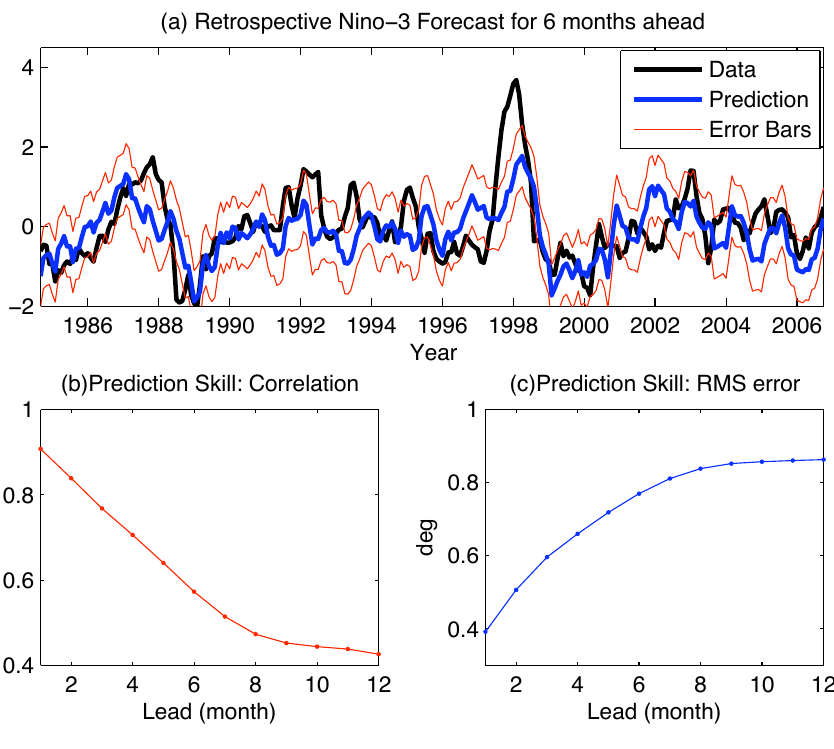
Fig. 14. ENSO forecasts by the SSA-MTM method. (a) Retrospective forecasts of the Ni˜no-3 SST anomalies for a lead time of 6 months. The forecasts (blue curve) for each point in the interval January 1984–February 2006 utilize only the appropriate part of the record (black curve) that precedes the initial forecast time; data ffrom the International Research Institute (IRI) for Climate and Society, http://iridl.ldeo.columbia.edu/SOURCES/.KAPLAN/.EXTENDED/. An SSA window of M = 100 months and 20 leading modes have been used. (b, c) Prediction skill for validation times of 1–12 months: (b) anomaly correlation and (c) root-mean-square (RMS) error, respectively. The one-standard deviation confidence levels (red curve) in panel (a) correspond to the RMS error for a lead time of 6 months given in panel (c) .